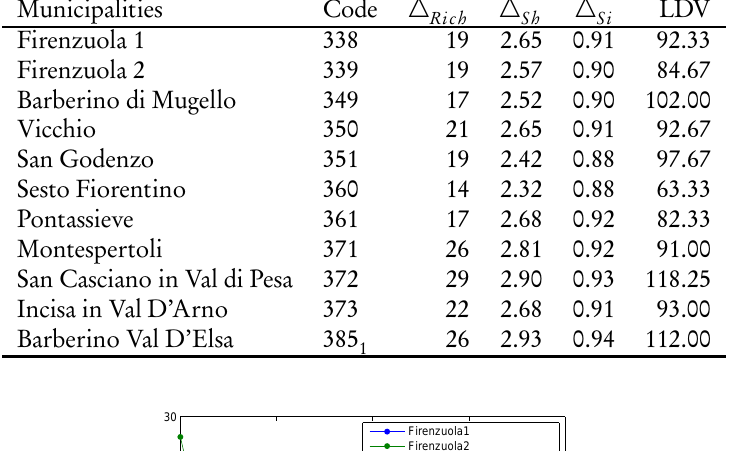
Classical diversity indices and LDV for the 11 stations.